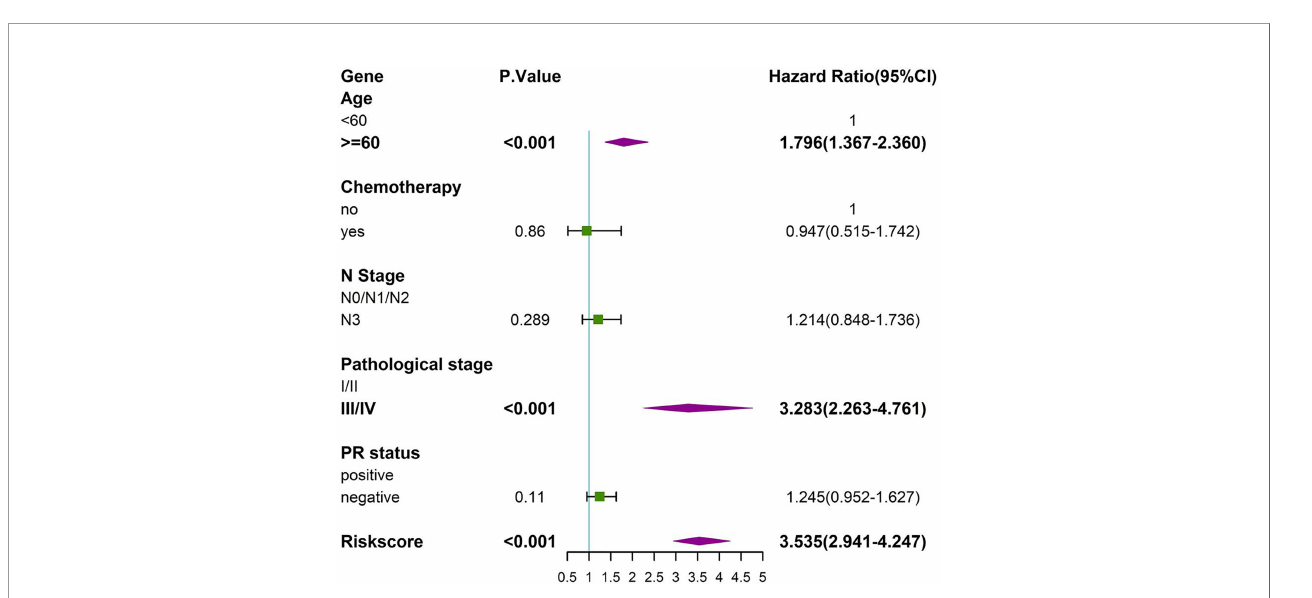
FIGURE 7 | Forest plot for multivariate Cox model in RT